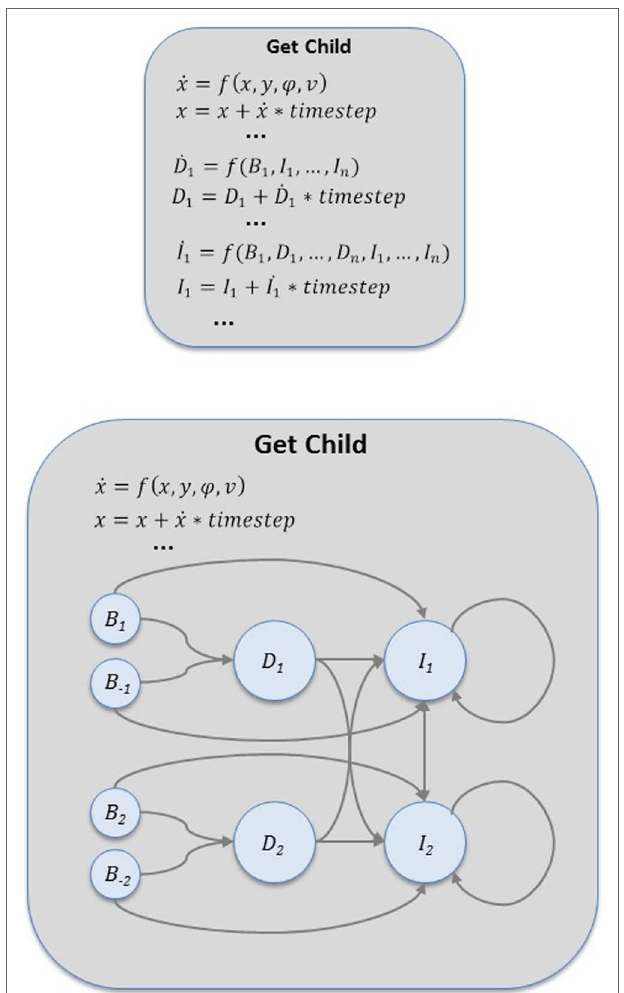
FIGURE 2 | Visualization of cognitive elements in a behavior (a mode ) in the hybrid dynamical system model of a DI-HDCA service robot (see section 4) . BDI-based cognitive elements – beliefs, desires, and intentions – are interconnected with excitatory and inhibitory links, expressed by differential equations in a dynamical system, which can be viewed as an atypical spreading activation network. Because both cognitive-level and physical-level components are expressed in the shared language of dynamical systems, physical behavior components such as speed or heading angle (not visualized here) can in principle also be part of the dynamical